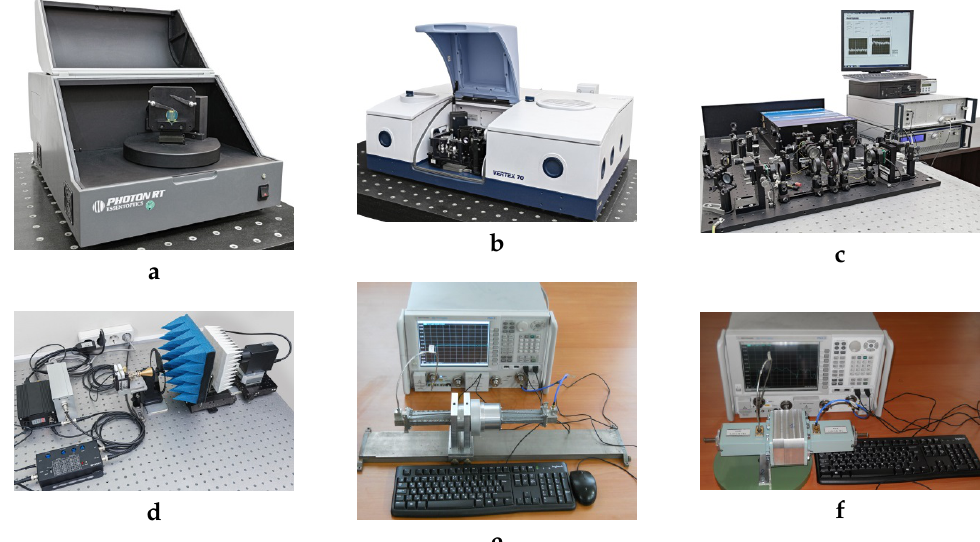
Figure 3. Experimental setups: a Photon RT spectrophotometer ( a ); a Bruker Vertex 70 Fourier- spectrometer ( b ); a Tera K8 Menlo Systems THz time-domain spectrometer ( c ); and setups to measure attenuation at frequencies of 99 GHz ( d ), 8–12 GHz ( e ), and 2.2–4 GHz ( f